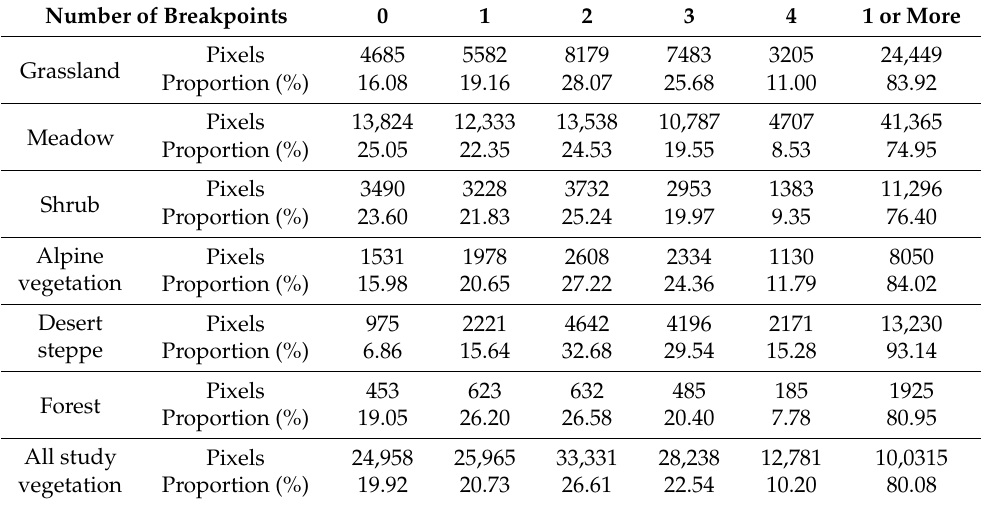
Table 1. Statistical results of the abrupt change pixels and percentage of different vegetation types for each number of breakpoints in the trend component between 2000 and